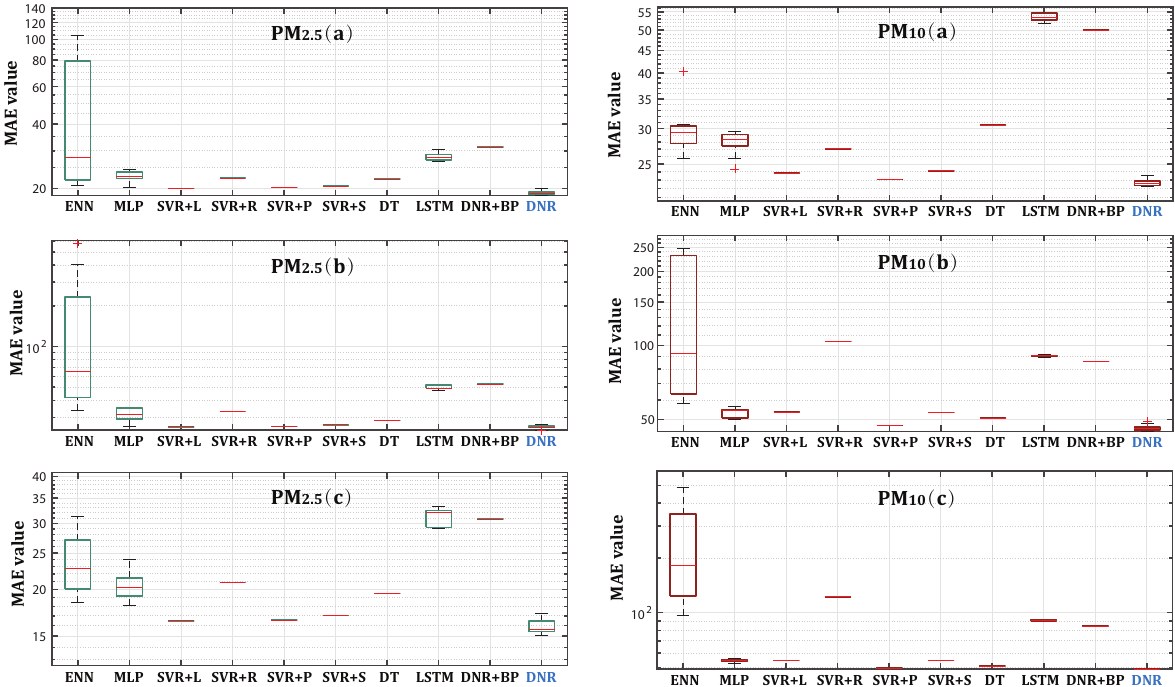
Figure 7. Box-and-whisker plots for the MAE of all prediction